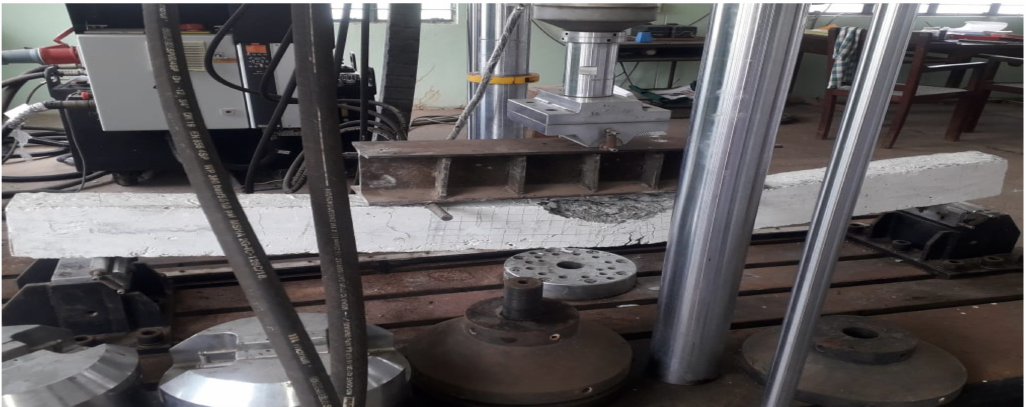
Figure 12. Failure pattern of RC